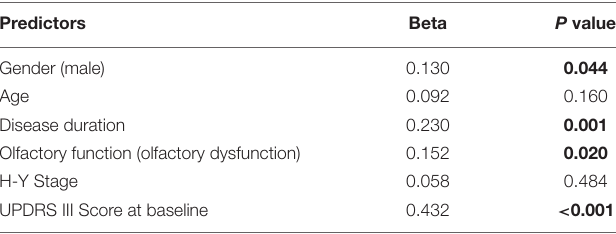
TABLE 4 | Multivariate linear regression analysis of clinical factors associated with UPDRS III score at year 1.